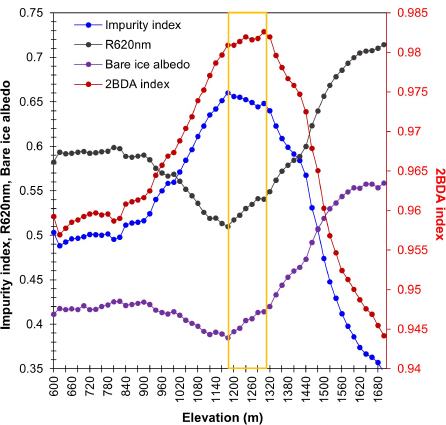
Figure A2. Spatial variations of the average 2BDA index, impurity index, 620nm reflectance, and MODIS albedo over bare ice at different elevations within the study area (20m elevation interval). For surface elevation, we used the 30m resolution MEaSUREs Greenland Ice Mapping Project (GIMP) Digital Elevation Model (Howat et al., 2014,